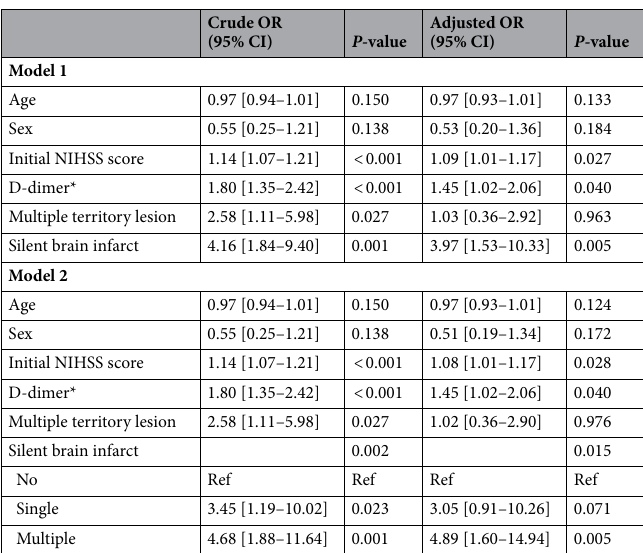
Table 2. Multivariable logistic regression for possible predictors of early neurological deterioration. NIHSS = National Institutes of Health Stroke Scale. *These variables were transformed using a log scale.